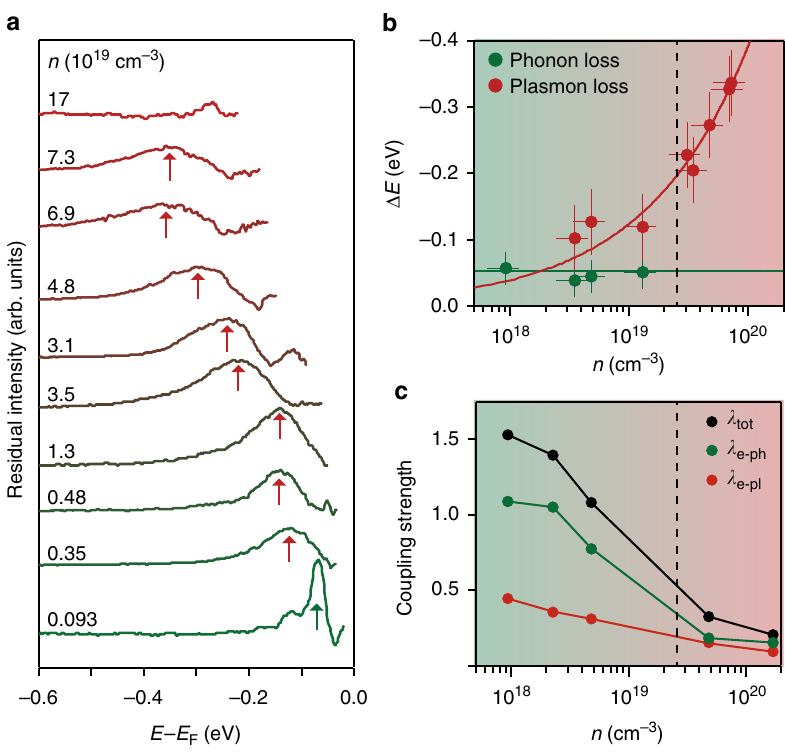
Fig. 4 Tuning and disentangling the interplay of electron − phonon and electron − plasmon coupling. a Normalised residual intensity plot of EDCs at the centre of the electron pocket (see Supplementary Fig. 3), revealing a clear satellite structure that shifts to higher binding energy with increasing charge carrier doping. b Fits to the measured raw EDCs reveal that the separation of this satellite from the quasiparticle band follows the functional form of a plasmon mode (see Methods), while an additional weak satellite feature is found to remain at a constant energy for the lower-doped samples, which we attribute to a phonon-induced replica band. Error bars re fl ect the uncertainty in extracting the Luttinger area and satellite binding energies from the experimental measurements, and incorporate statistical errors in peak fi tting as well as systematic experimental uncertainties. c Decomposition of the coupling strength to phonon and plasmon modes from the ab initio calculations reveals a rich carrier-density-driven crossover in the underlying nature of dominant many-body interactions in this